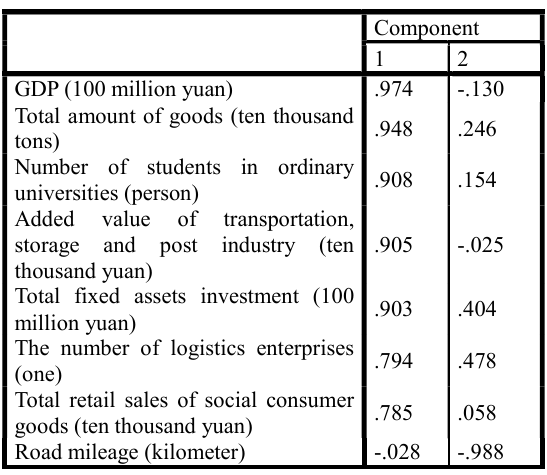
Table 3-2 The rotated component matrix a